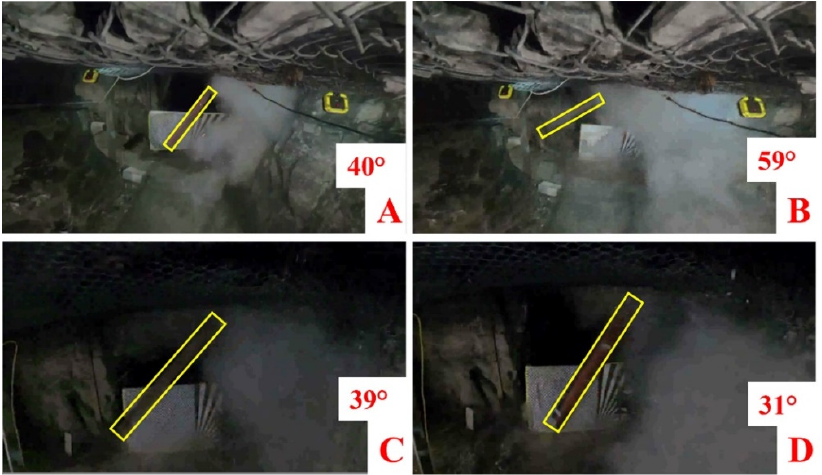
Figure 6. ( A ) Traditional dynamite charge 4 ms after initiation ( B ) Dynamite water charge 4 ms after initiation ( C ) Half dynamite water charge 4 ms after initiation ( D ) Quarter dynamite water charge 4 ms after